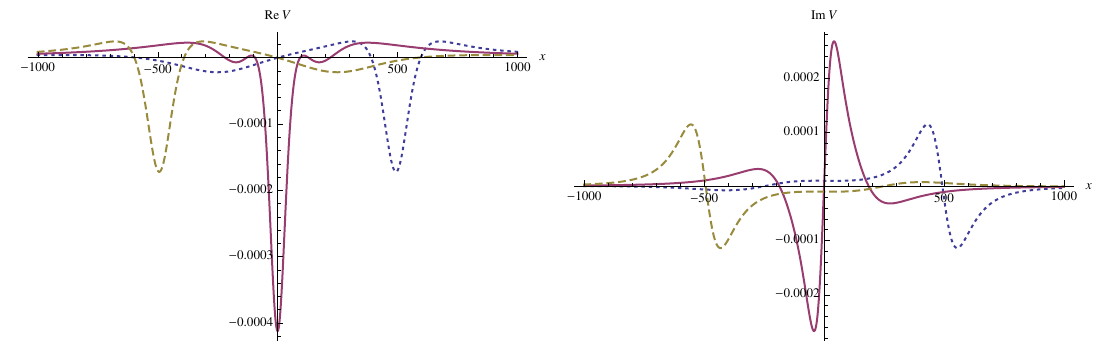
Figure 3 . Evolution of real (on the left) and imaginary (on the right) parts of potential (2.33), (2.35) as a complex -symmetric solution of the KdV equation (2.4) at α = 100, ν = 5; dashed lines: PT t = 10 7 , continuous lines: t = 0, dotted lines: t = 10 7 −